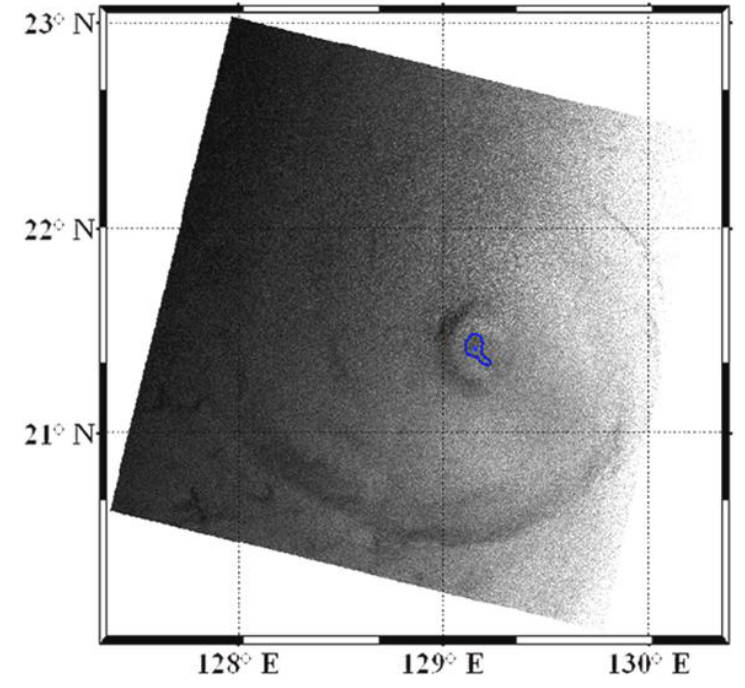
Figure 5. Envisat SAR image with the eye boundaries delineated using wavelet analysis for Typhoon Talim on 30 August